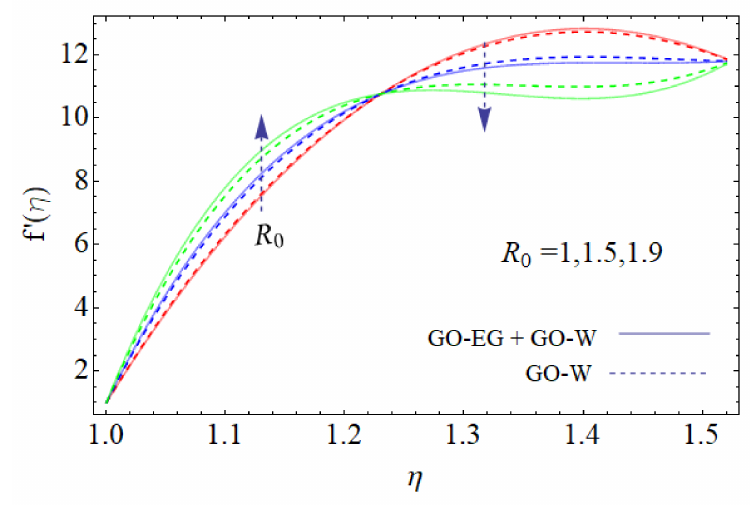
Figure 9. Influence of the rotation parameter on the velocity profile.